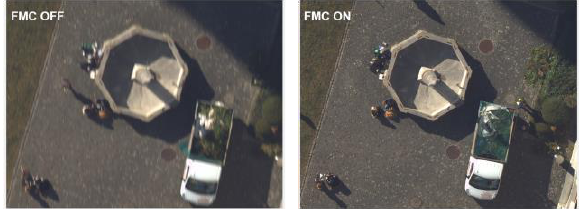
Figure 2: Leica MFC150 with FMC off/on - showing the benefit of FMC for long exposure at low sun angle (1/200 sec at 120 kn) The principle of oblique viewing angels for the modelling of vertical surfaces is widely used in 3D city modelling. To use the advantage of an oblique viewing angle together with an active LiDAR system results in a LiDAR system with a conical scan pattern as shown in Figure 3. With this, vertical structures are well represented in the resulting point cloud in all viewing directions (Figure 4).